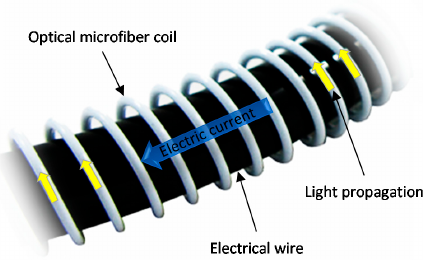
Figure 6. Schematic diagram of the microfiber-coil sensor head.